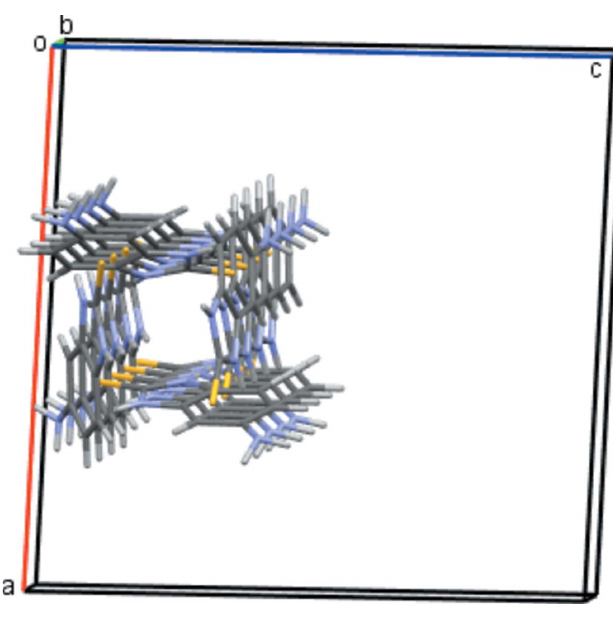
Figure 4 Projection of a tube in the b -axis direction.